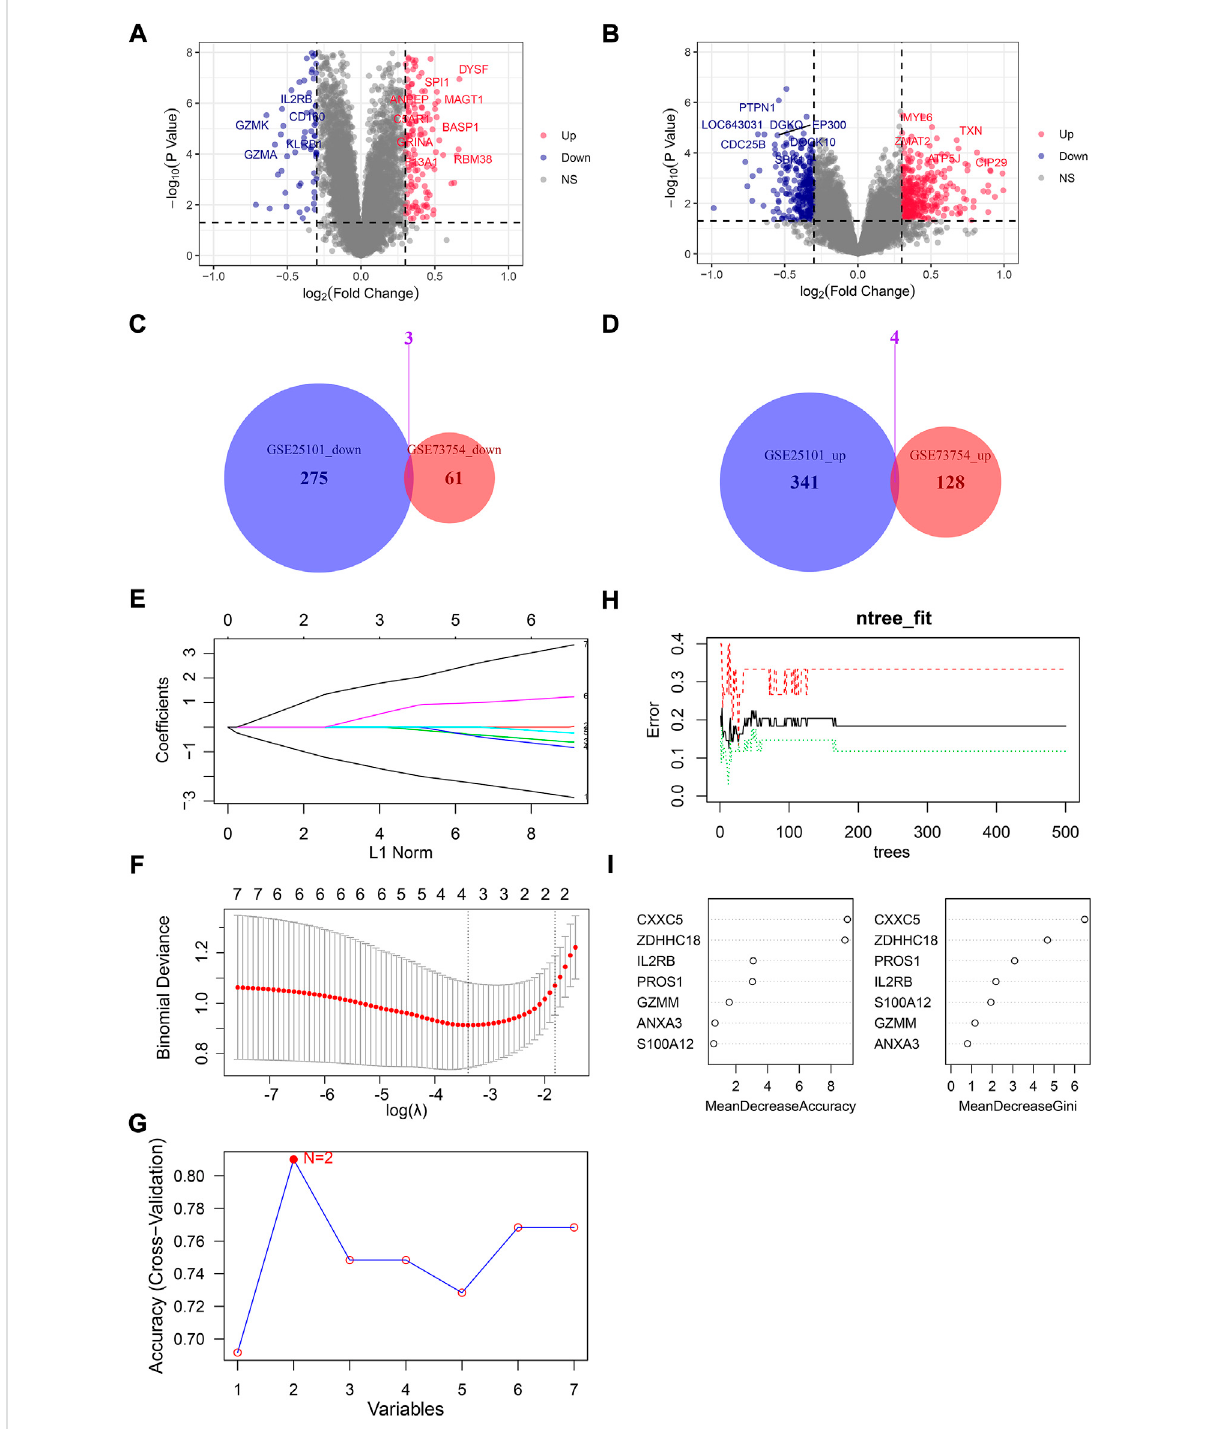
FIGURE 1 Screening for hub genes from DEGs between normal people and AS patients. The volcano plot for DEGs in GSE73754 (A) and GSE25101 (B) : x -axisrepresentslog 2 (foldchange)ofgeneexpressionsinASpatientscomparedwithnormalcontrols,whilethe gene expression between AS patients and normal controls. (C) Venn plot for downregulated DEGs in GSE73754 and GSE25101. (D) Venn plot for upregulated DEGs in GSE73754 and GSE25101. (E) LASSO coef fi cient pro fi les for the seven common DEGs in the ten-fold cross-validations. (F) Partial likelihood deviance with changing of log( λ ) plotted by LASSO regression in ten-fold cross-validations. (G) Filtering characteristic genes using the SVM-RFE algorithm: accuracy for models with different numbers of variables: the x -axis represents the number of variables involved in the models and the y -axis represents the corresponding accuracy of cross-validation of the models. (H) Relationship between the number of decision trees and the error rate of the model in RF. (I) Selecting hub genes by variable importance measures for